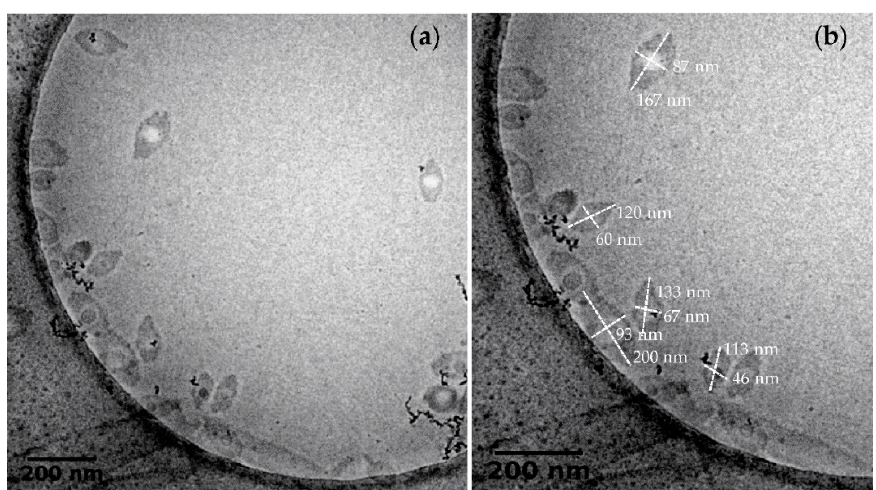
Figure 8. ( a, b ) Cryo-TEM micrographs of PNVCL- b -PCL (1) micelles. Figure 8. ( a , b ) Cryo-TEM micrographs of PNVCL- b -PCL (1) micelles.